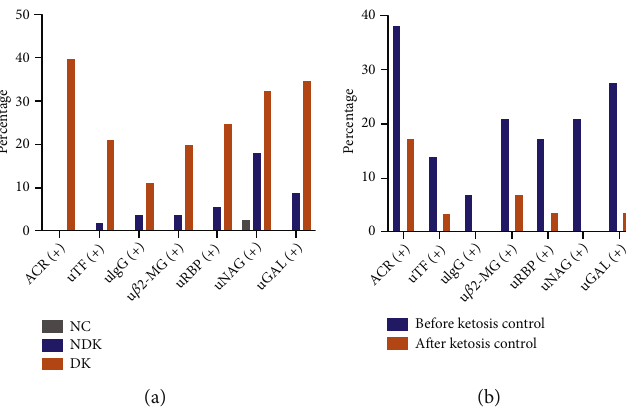
Figure 2: Percentages of patients with increased glomerular and tubular injury in DK patients. ACR, albumin creatinine ratio; u β 2-MG, urine β 2-microglobulin; uGAL, urine β -galactosidase; uIgG, urine Immunoglobulin G; uTF, urine Transferrin; uNAG, urine N-acetyl- β - glucosaminidase; uRBP, urine retinol-binding protein; NC, normal control; NDK, non-diabetic ketosis; DK, diabetic ketosis. ACR ≥ 30mg/ g was de fi ned as ð + Þ , c2 = 45 : 446, p < 0 : 001 between NC,NDK, and DK groups, c2 = 3 : 107, p = 0 : 07 between before and after ketosis control; urine β 2-MG ≥ 0.3mg/l was de fi ned as ð + Þ , c2 = 14 : 960 , p = 0 : 001 between NC, NDK, and DK groups, c2 = 2 : 320 , p = 0 : 128 compared before and after ketosis control; urine GAL ≥ 15U/l was recorded as ð + Þ , c2 = 25 : 505, p < 0 : 001 , between NC, NDK, and DK